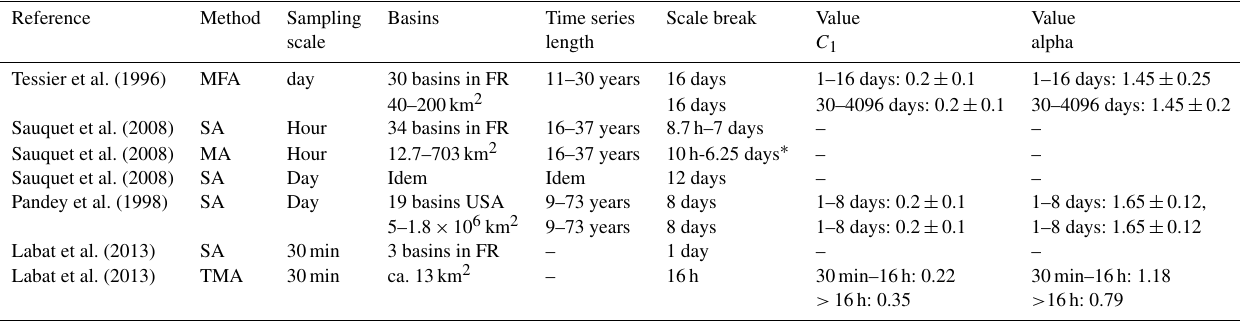
Table 1. Summary of results reported on the literature for (multi)fractal analysis of hydrological flows. MA: moment analysis, MFA: multi- fractal analysis, SA: spectral analysis, TMA: trace moment